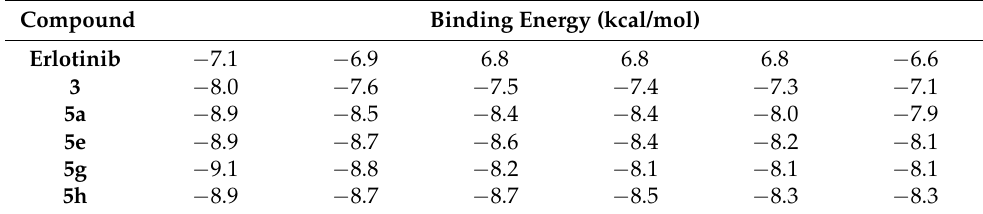
Table 2. Binding energies of promising cytotoxic agents. Compound Binding Energy